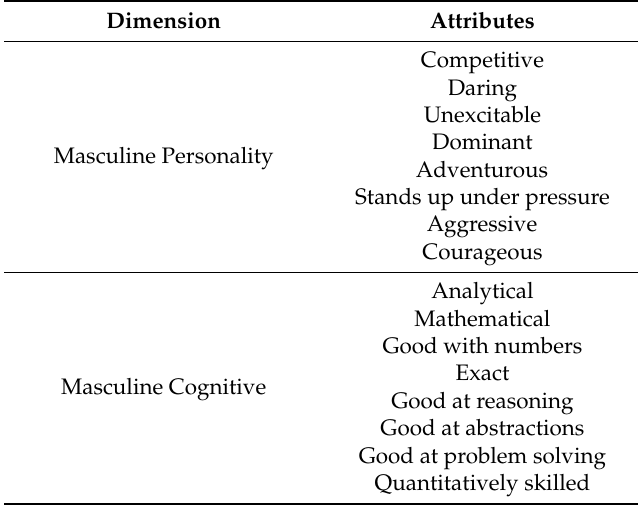
Table 1. Description of Masculine Dimensions (Cejka and Eagly